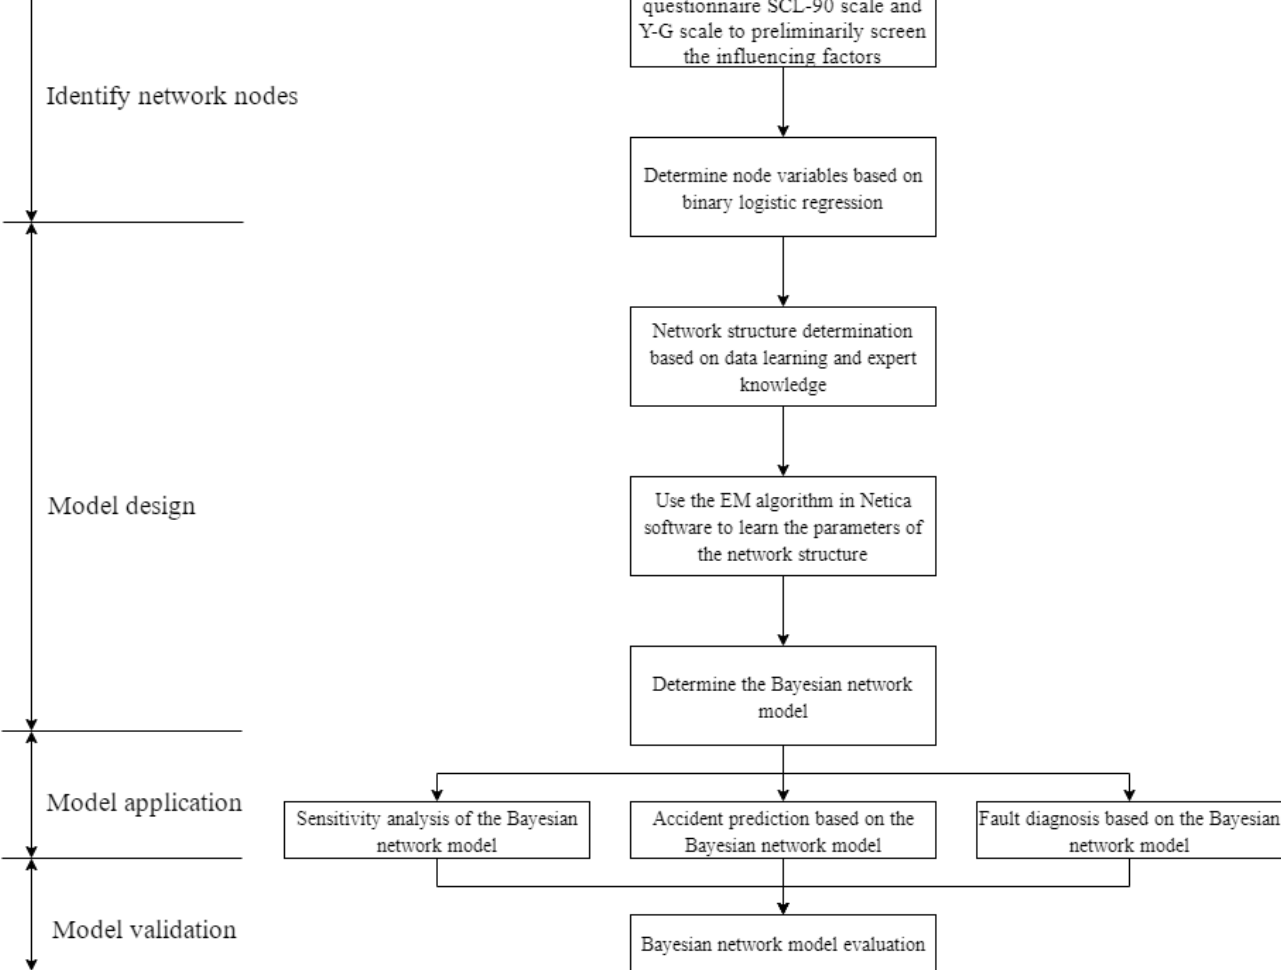
Figure 1. Flow of constructing the Bayesian network model for evaluating bus drivers’ mental health and traffic safety.